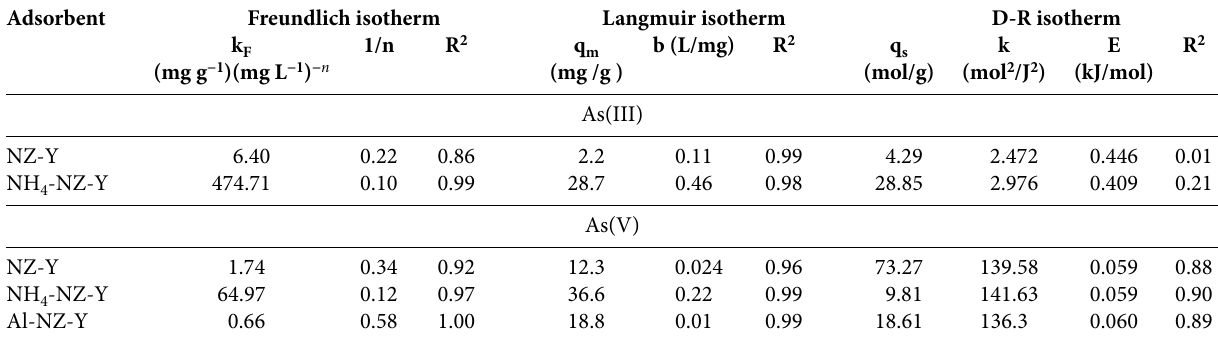
Table 5. Adsorption constants for removal of arsenic (III, V) from aqueous solution with natural and modified zeolites Adsorbent Freundlich